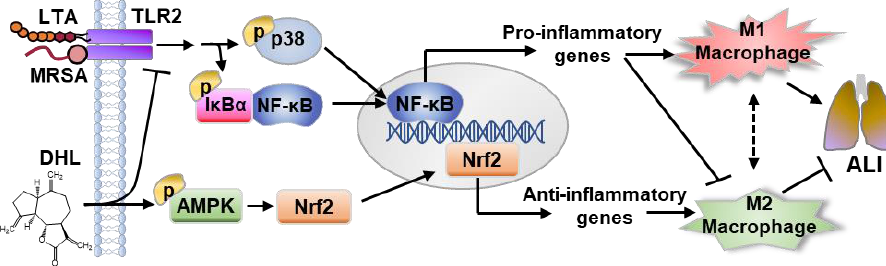
Figure 7. Scheme for the proposed mechanism of DHL in the prevention of MRSA-induced ALI. The mechanism involves DHL inhibiting M1 polarization and promoting M2 polarization, and includes the roles of p38/NF-κB inhibition and AMPK/Nrf2 signaling pathway activation.